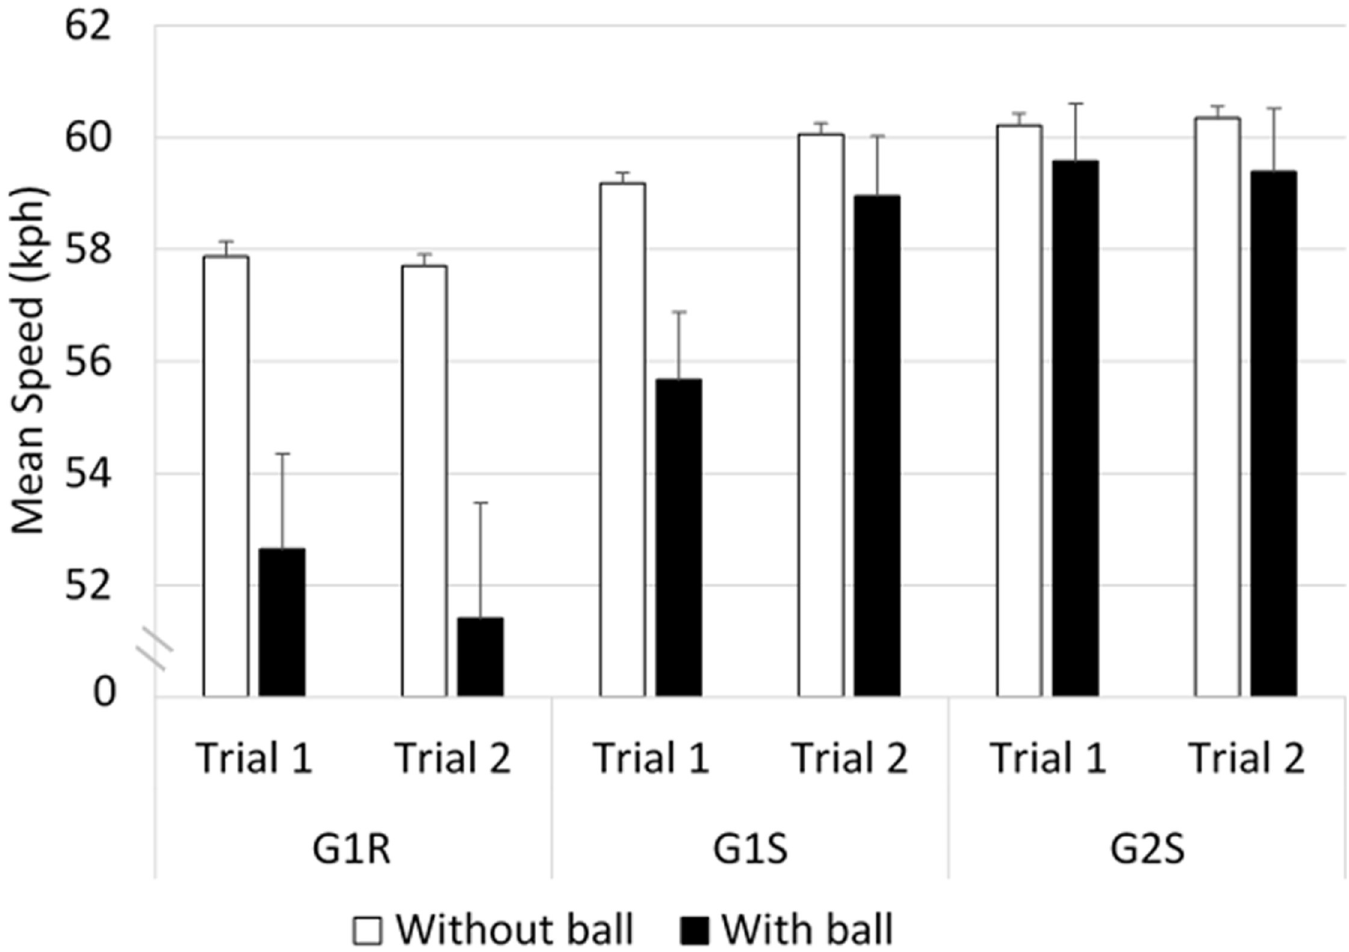
Fig 8. Mean speed displayed on the